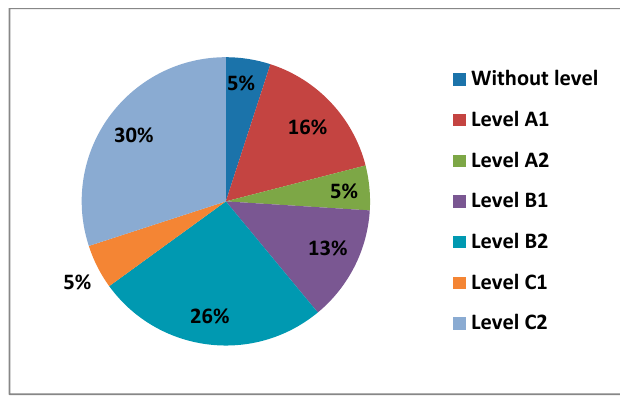
Figure 26. Level of digital competence in teachers in Area 5.